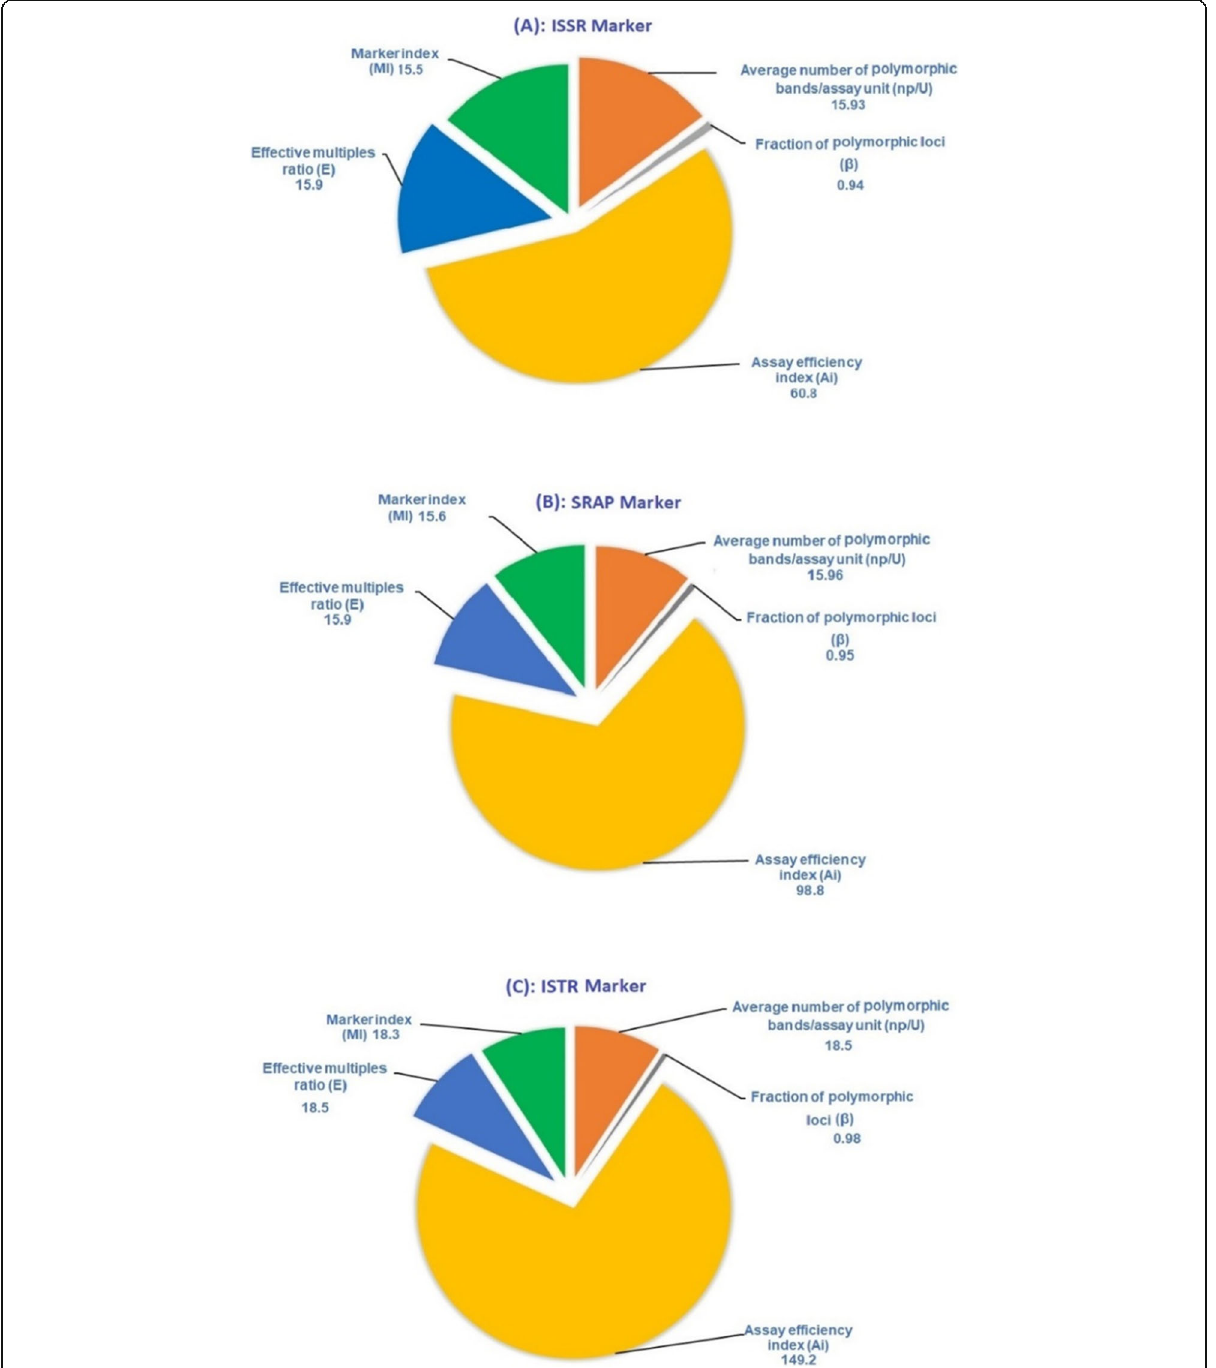
Fig. 5 Observed the comparison information obtained and the discriminating capacity of a ISSR, b SRAP, and c ISTR profile among 12 Capparaceae